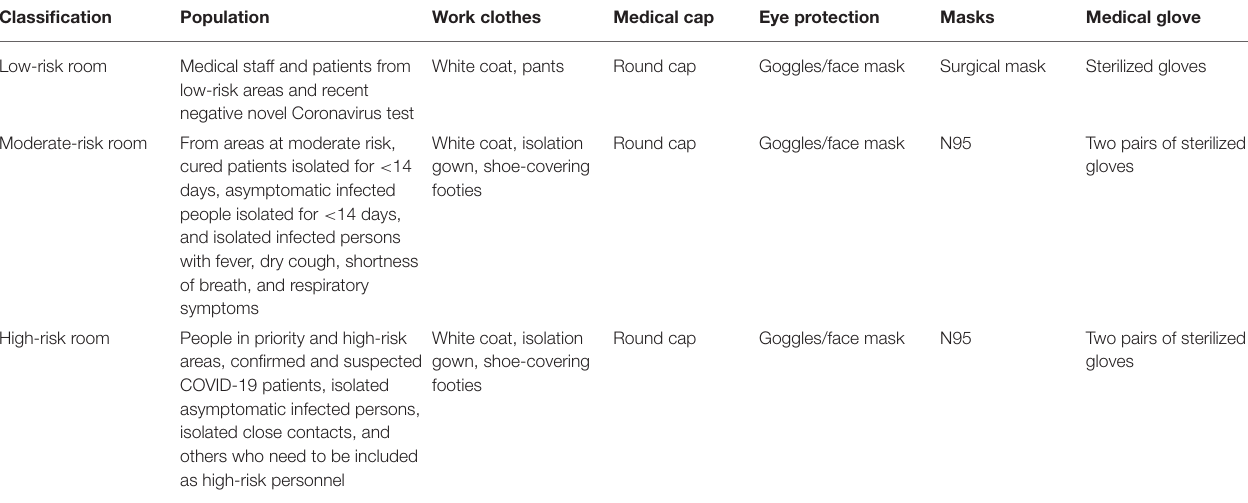
TABLE 2 | Medical treatment room classification and level of